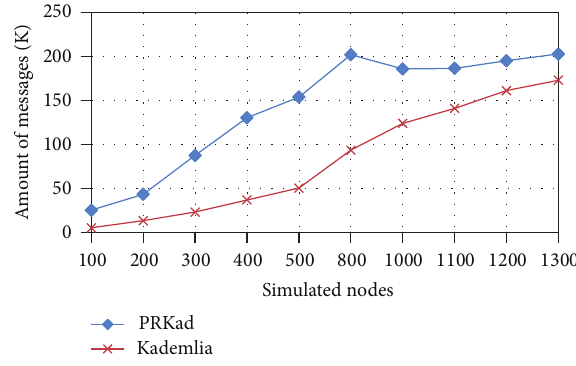
Figure 11: Amount of messages used in simulations.